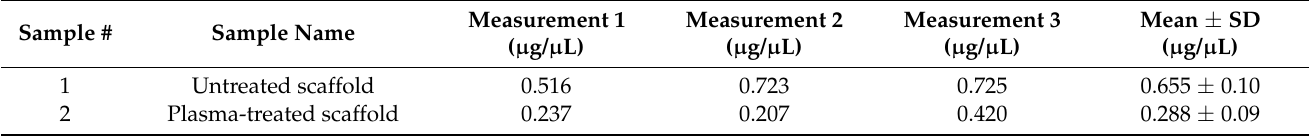
Table 5. Concentration of the collagen released into PBS++ (3D bioplotted scaffolds).